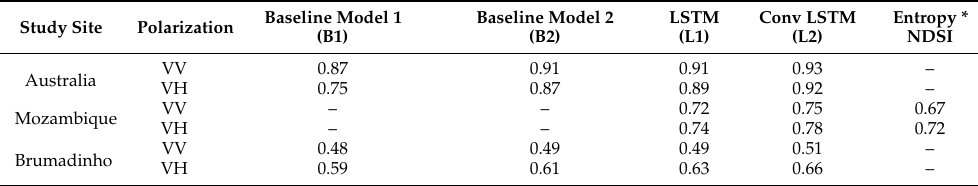
Table 5. Summary of Kappa values obtained in the three study